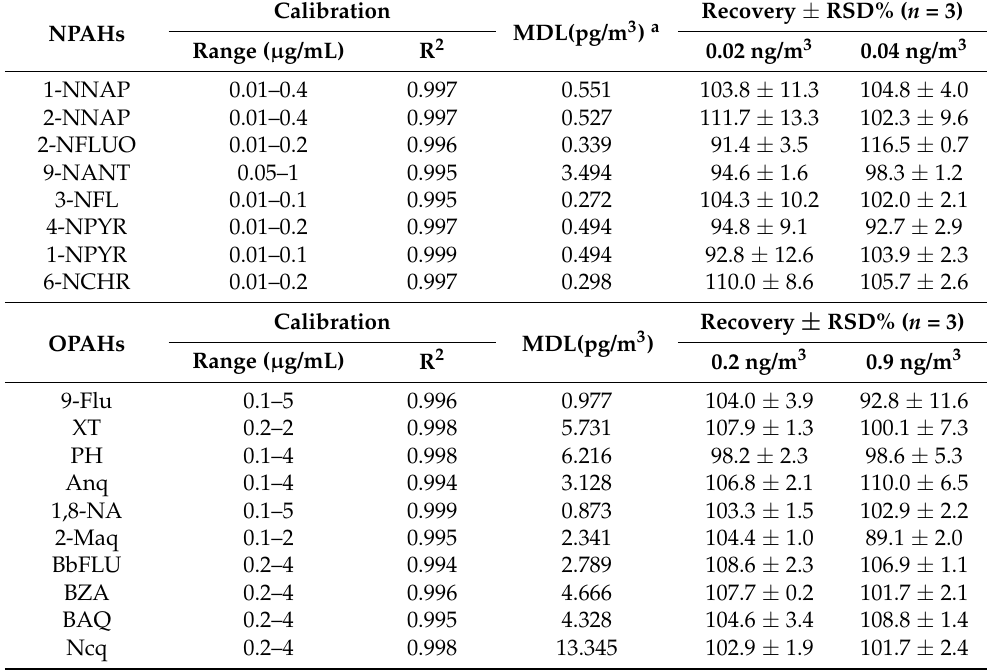
Table 2. Calibration linear regression value, MDLs, and recoveries of individual NPAH and OPAH congeners obtained by the analytical